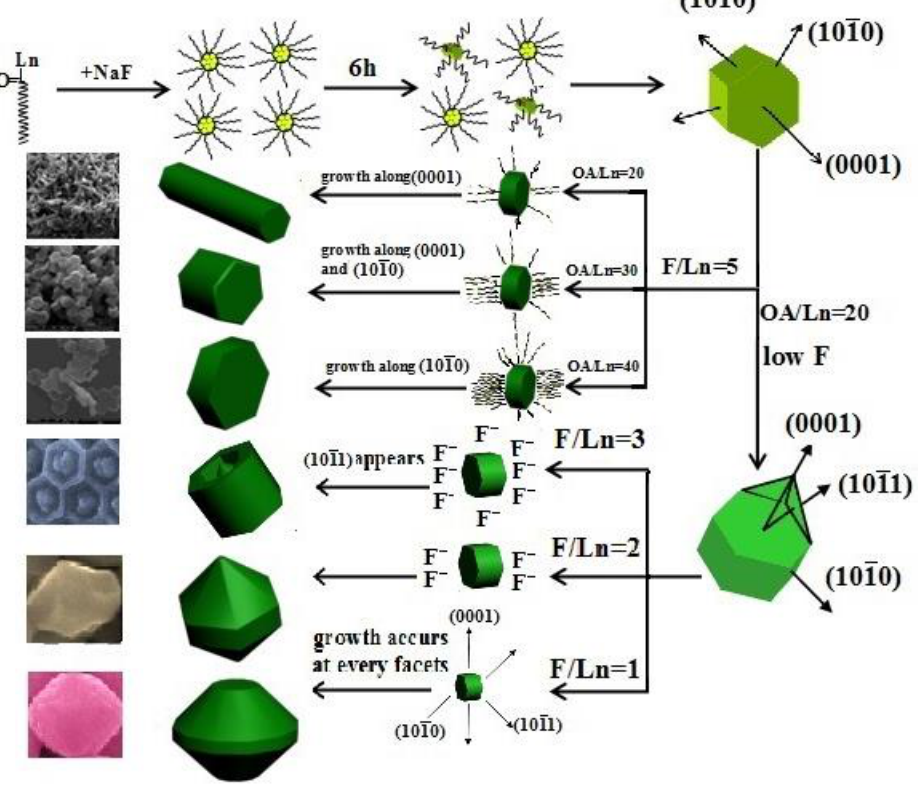
Scheme 1. Schematic illustration of the possible formation mechanism of NaYF